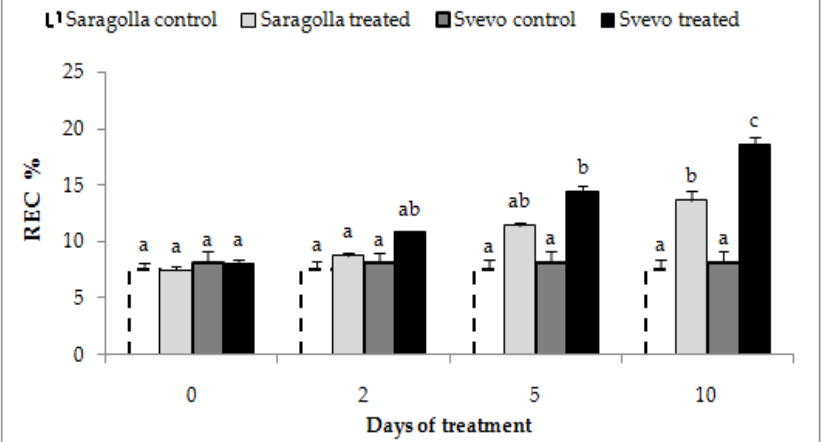
Figure 3. Electrolyte leakage from roots of Saragolla and Svevo seedlings subjected to osmotic stress. Seven days-old Saragolla and Svevo seedlings were subjected to osmotic stress treatment for 10 days, by means of 18% PEG-6000 administration, and after 2, 5 and 10 days the REC% of roots was measured as reported in Section 4.3, and values compared to those of control, unstressed seedlings. Results from three independent experiments are reported; values are expressed as the mean ± SD. Statistical significance was attributed by one-way ANOVA test. Bars labeled with dissimilar letters are significantly different ( p < 0.05).